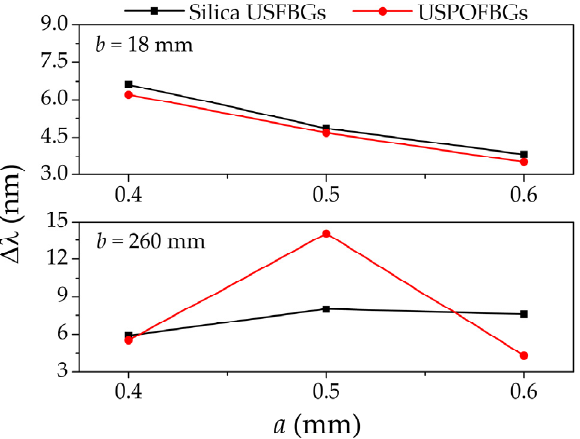
Figure 7. Bandwidth variation as function of the slit widths for silica USFBGs and USPOFBGs when b is 18 mm and 260 mm.